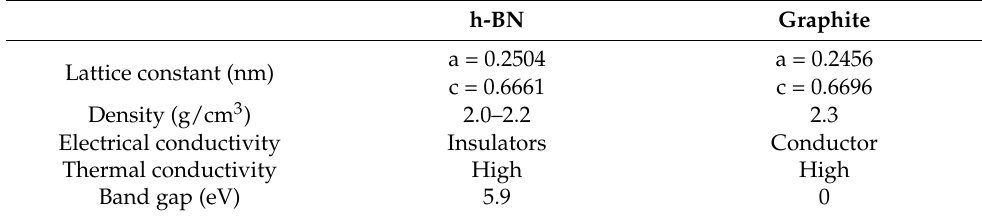
Table 2. Comparison of h-BN and graphite properties [14,24,28]. h-BN Graphite Lattice constant